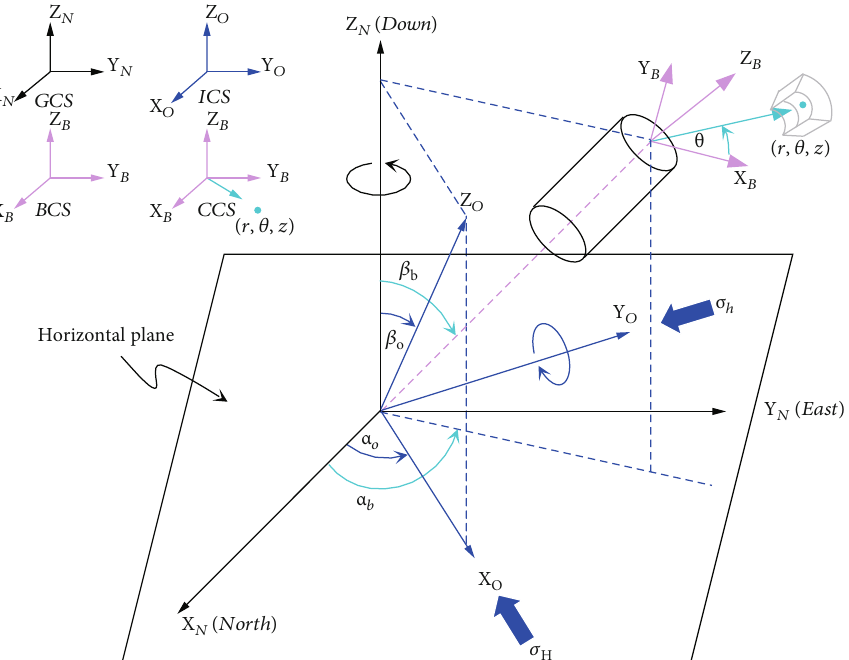
Figure 1: The relationship between di ff erent coordinate systems.